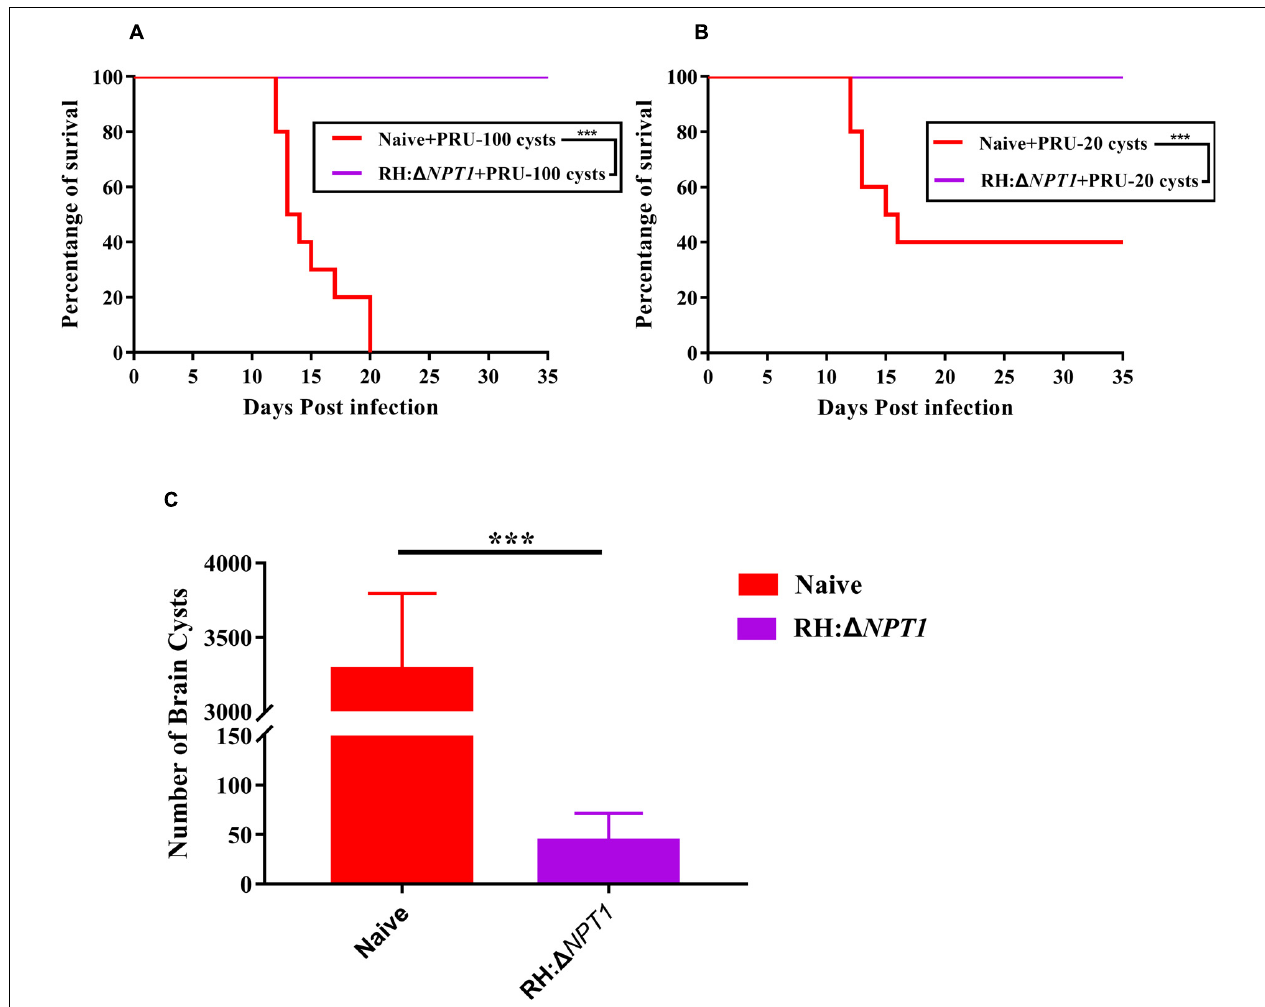
FIGURE 6 | RH: (cid:49) NPT1 vaccination promotes survival and reduced cysts loads in the brain. (A,B) Survival curves derived from mice infected with 20 or 100 cysts of the Pru strain. Compared with non-immunized mice, all of the vaccinated mice survived the challenge ( n = 10; ∗∗∗ P < 0.001; n.s., not significant; Mantel–Cox-test). (C) Protection efficiency of RH: (cid:49) NPT1 against chronic infection was determined by cyst burden assays. Compared with the non-immunized mice, cyst burden in the brains of immunized mice were significantly reduced after the mice were infected with 20 cysts of the Pru strain. Significance was determined by ANOVA ( n = 6; ∗∗∗ P < 0.001; n.s. , not